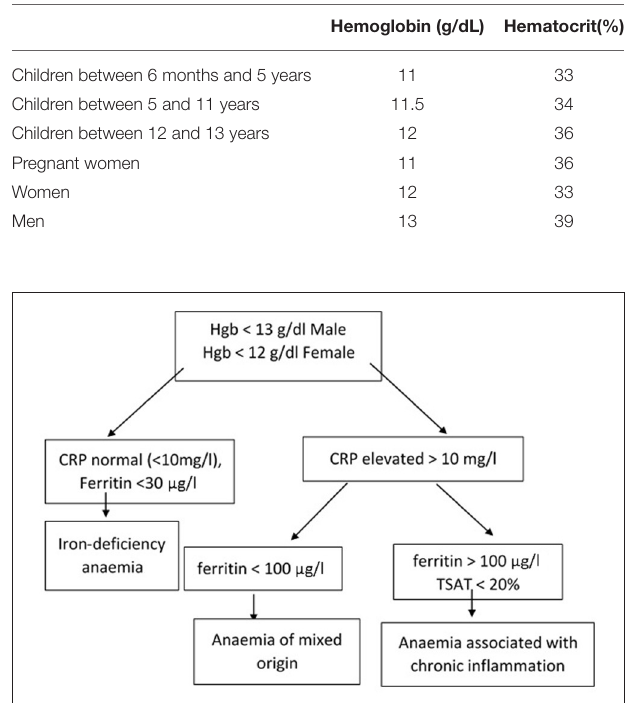
FIGURE 1 | Differential diagnosis of IDA and chronic inflammation–associated iron